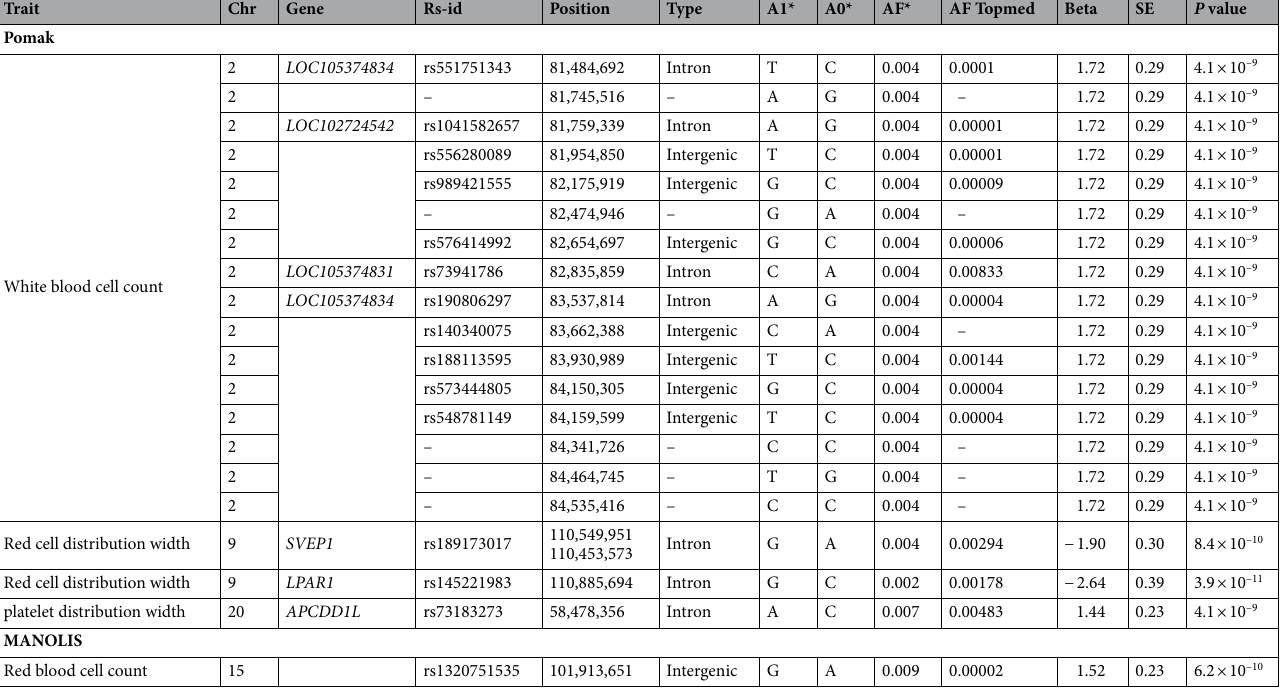
Table 1. Association results of the lead SNPs of novel genome-wide significant loci with haematological traits. Betas are reported in units of standard deviation of the traits. The lead SNP for the locus on chromosome 2 is represented by 16 variants in perfect linkage disequilibrium covering an area of 3 Mb.*A0 is the reference allele and A1 is the effect allele for which the allele frequency (AF) is reported in the current sample and in